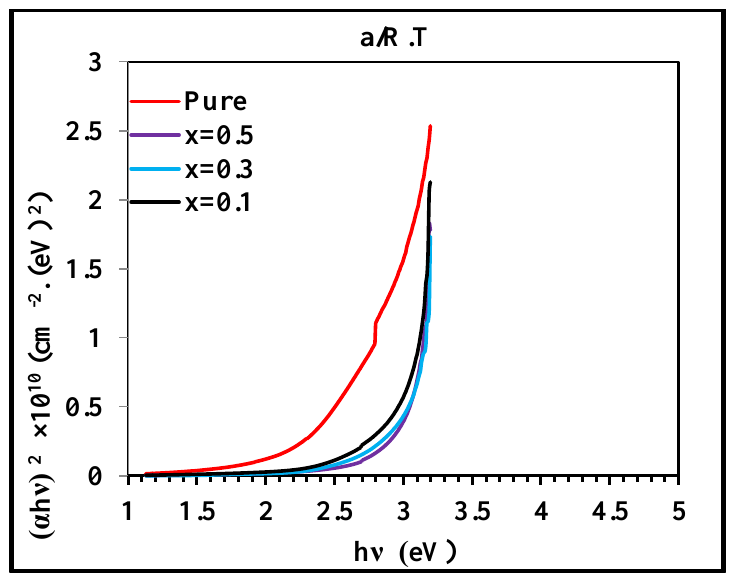
Fig. 4: Optical energy gap for V